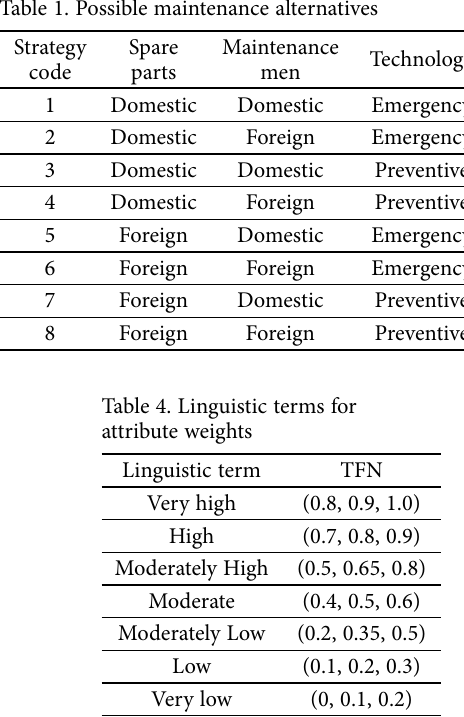
Table 2. Quantitative attributes: information on different mainte-